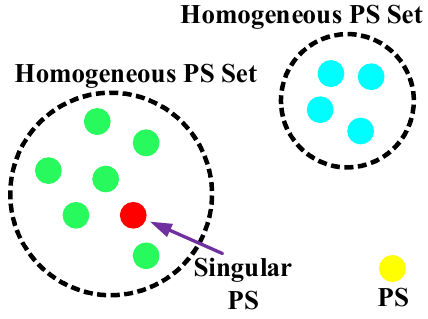
Figure 1. Illustration of the PS (persistent scatterer) clustering process.